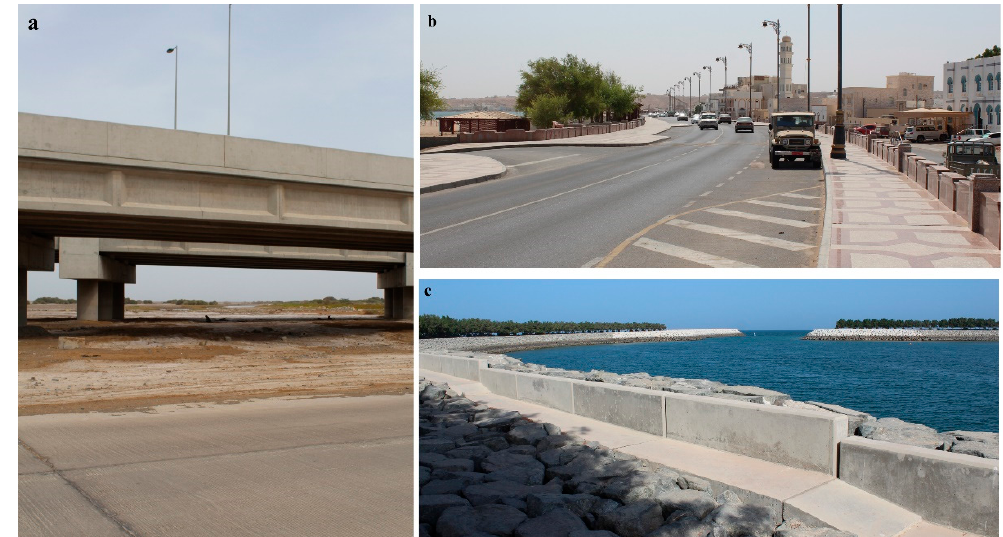
Figure 9. Coastal hard structures against the sea-level rise. Note the elevated coastal highway in Al-Bainah ( a ) and Sur ( b ). Coastal protection extends to private coastal resorts ( c ).